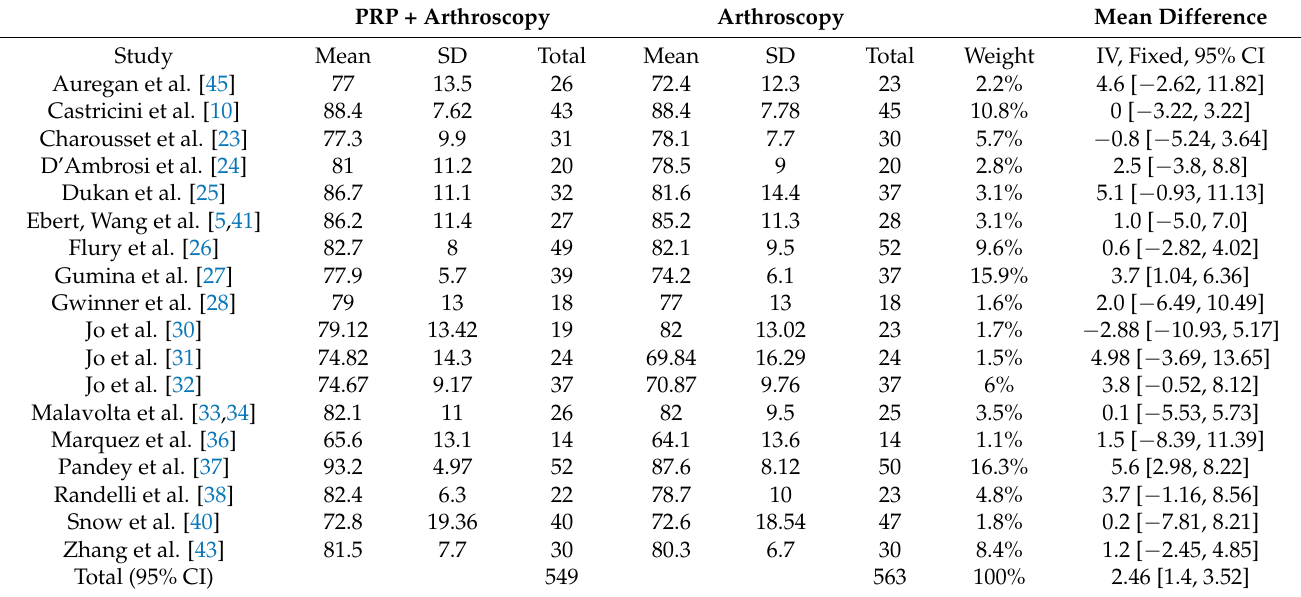
Table 3. Comparison of post-operative Constant–Murley scores between PRP and control group at final